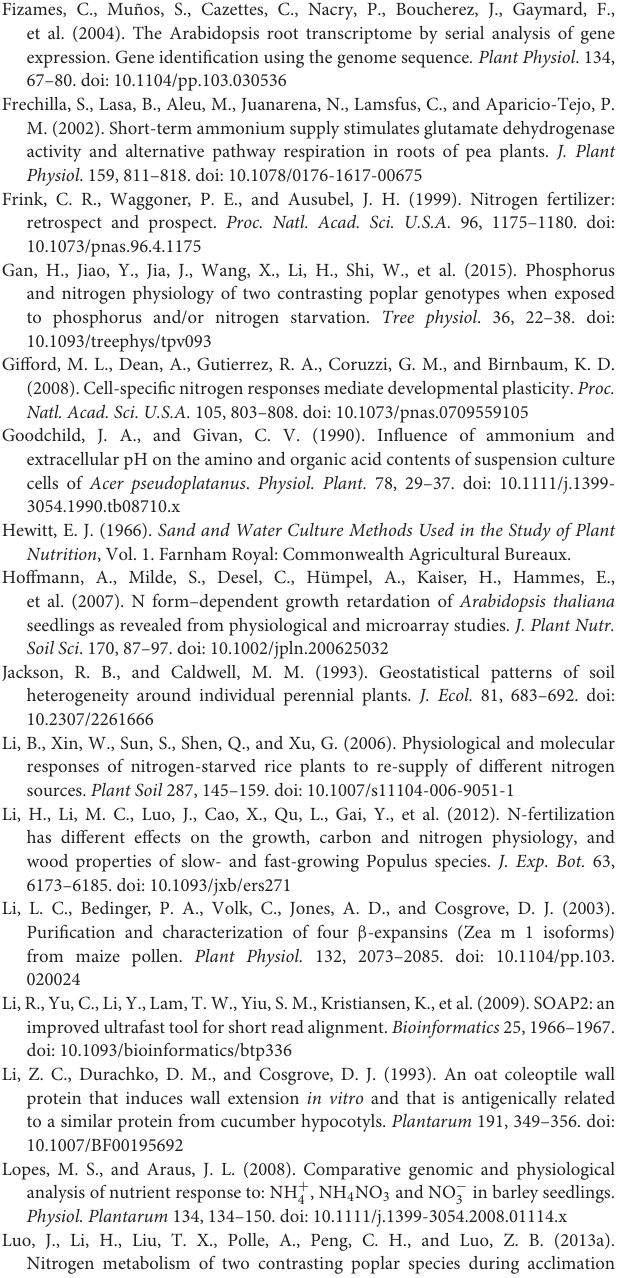
Table S5 | The annotation results of expression pattern clustering analysis. Figure S1 | Morphological parameters of poplar roots under different N forms for 21 days. Upper: a whole seedling under different N forms, respectively; Lower: a detailed root structure. Table- dry root weights. Values are the mean of four replicates ± SE. Different letters mean significant difference at a significance of 0.05 through ANOVA analysis and Duncan’s test. Figure S2 | Validation of RNA-SEQ results by real-time PCR; r is the correlation coefficient value between the two platforms. Figure S3 | Alidation of nitrogen metabolism-related genes expression by real-time